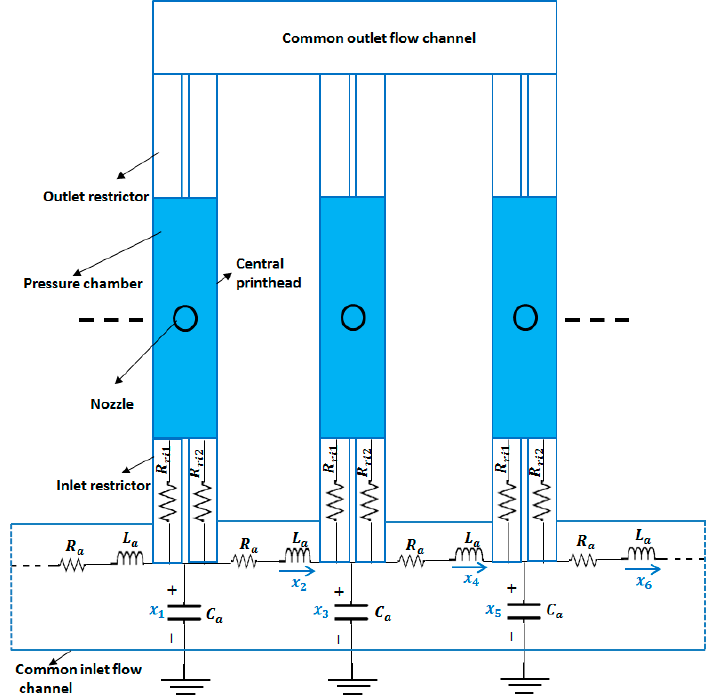
Figure 17. Array of multiple printheads with an equivalent electrical circuit model at the common inlet flow channel.